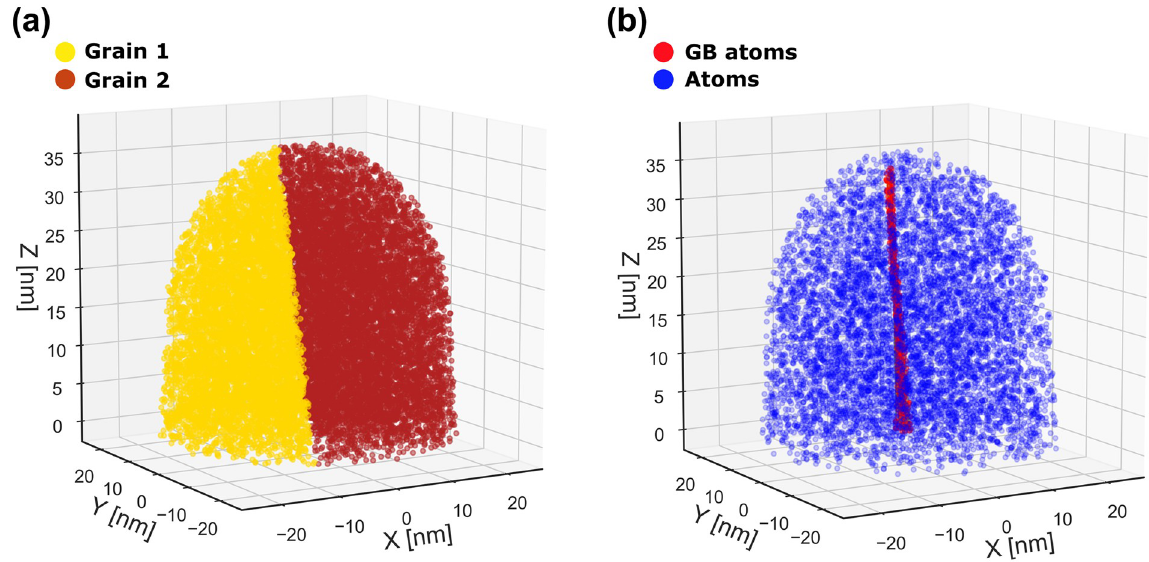
Fig 9. (a) TAPSim specimen geometry. The grain boundary normal is set to n h (Eq 1). (b) Reconstruction from TAPsim detector hit map using